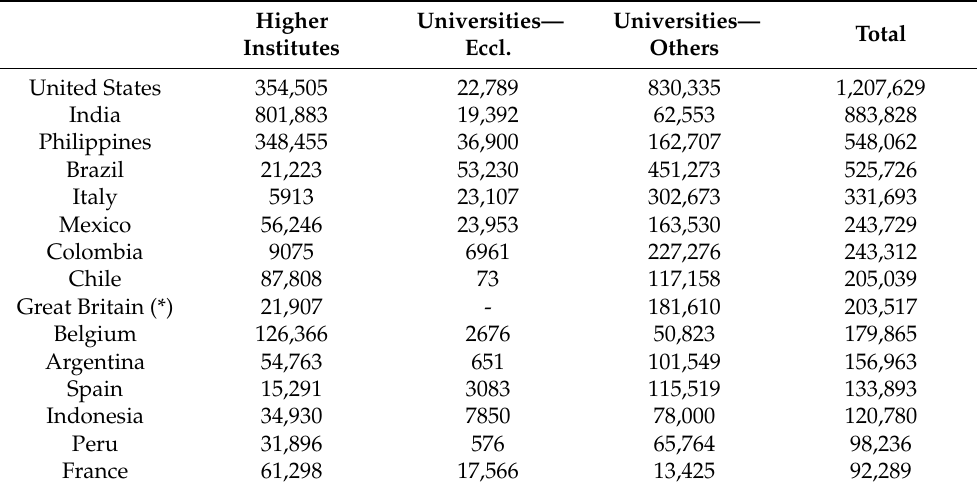
Table 4. Top 15 countries by enrollment in Catholic higher education, 2020.